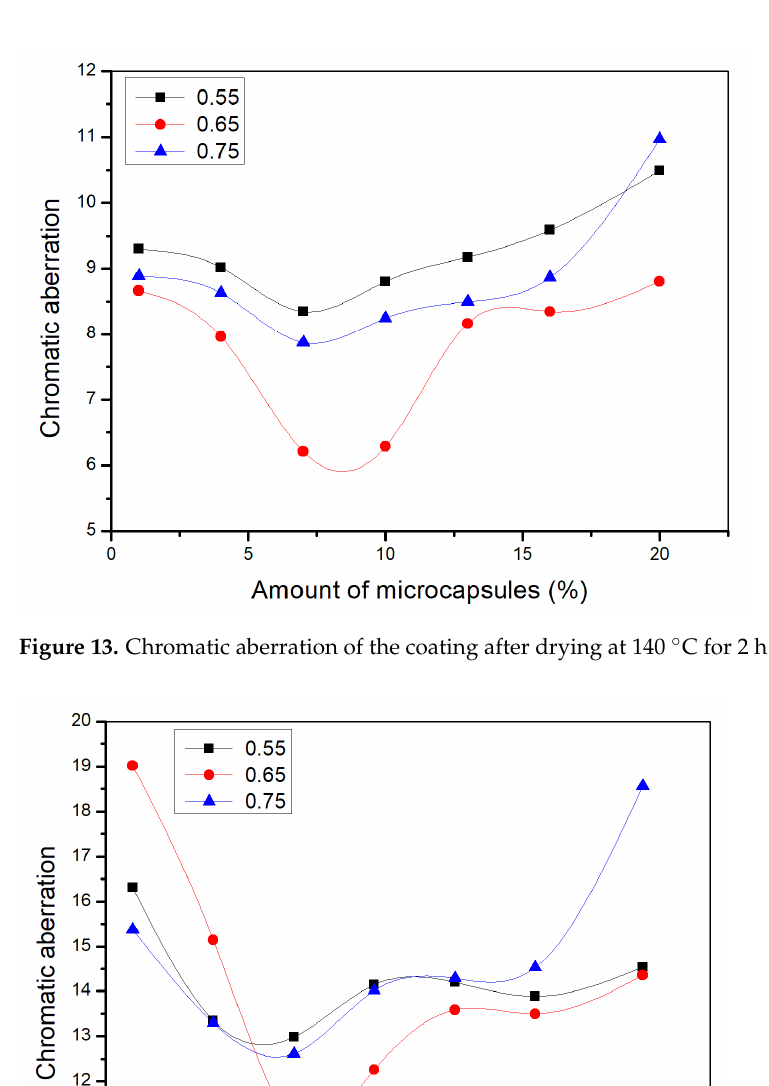
Figure 12. Chromatic aberration of the coating after drying at 120 °C for 2 h.